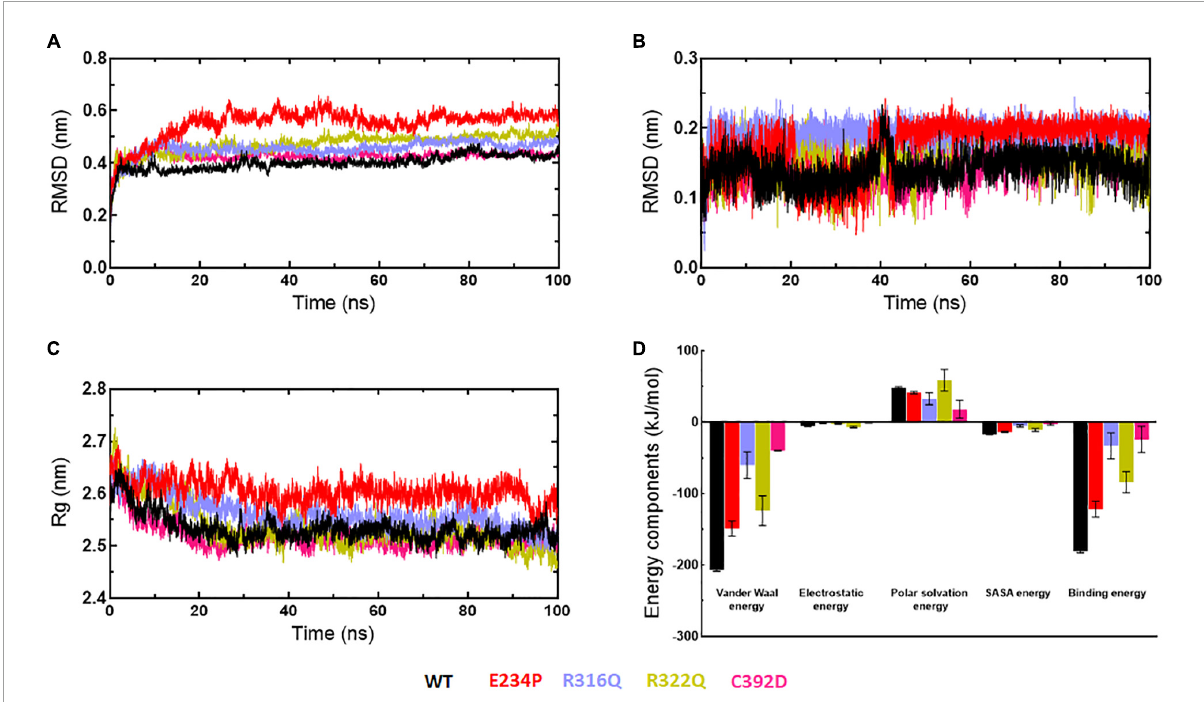
FIGURE9 MD simulation profiles of WT and MT-6mA complexes. (A) RMSD profiles of WT and different MT proteins, (B) RMSD profiles of 6mA substrate in complexed with WT and different MTs, (C) radius of gyration plots of WT- and MT-6mA complexes, and (D) interaction energy plot of WT- and MT-6mA. WT, E234P, R316Q, R322Q, and C392D were labeled in black, red, blue, mustard, and magenta color, respectively. Different interaction energies were measured in kilocalorie per